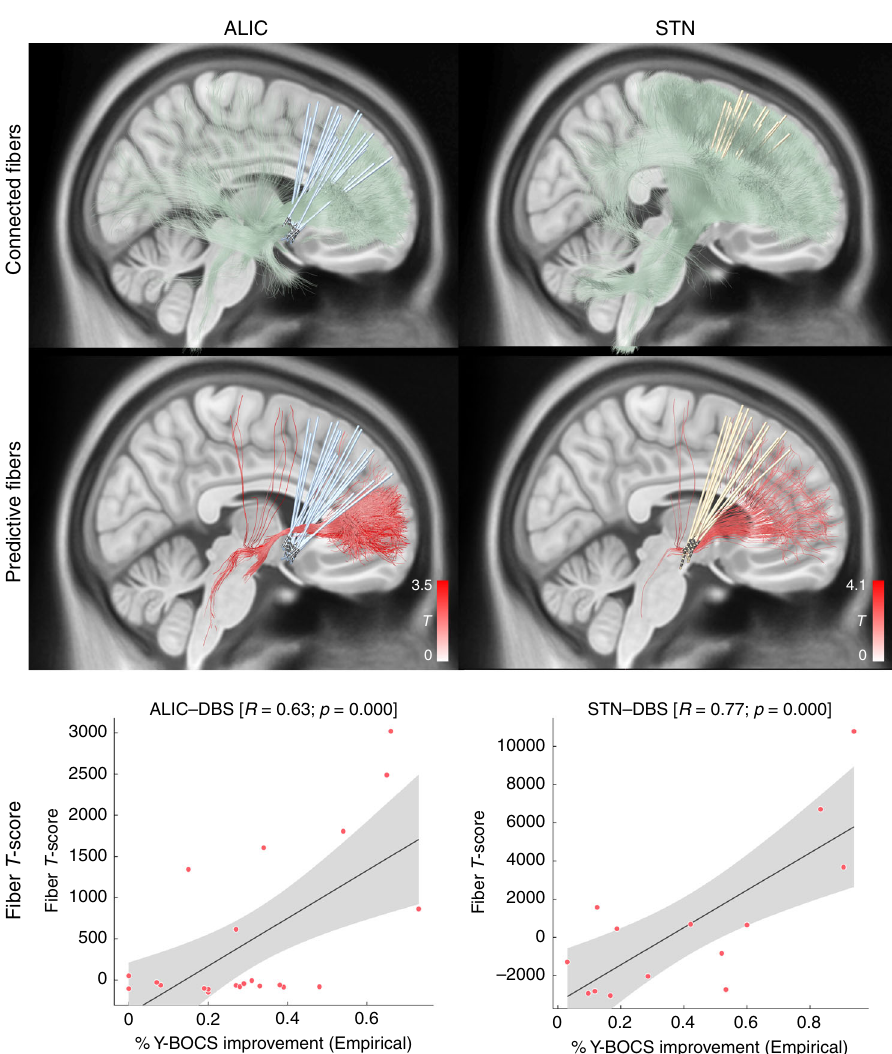
Fig. 2 Predictive fi ber tracts in training cohorts. Top: all fi bers connected to the sum of volumes of tissue activated (VTAs) of each cohort are shown in green. Middle: predictive fi bers positively associated with clinical improvement are shown in red. Only positive fi bers are shown here for reasons of clarity. See Fig. 3 for negatively associated tracts. The top 20% predictive fi bers are displayed. Bottom: correlations between the degree of stimulating positively predictive tracts (sum of aggregated fi ber T -scores under each VTA) and clinical improvements. Gray shaded areas represent 95% con fi dence